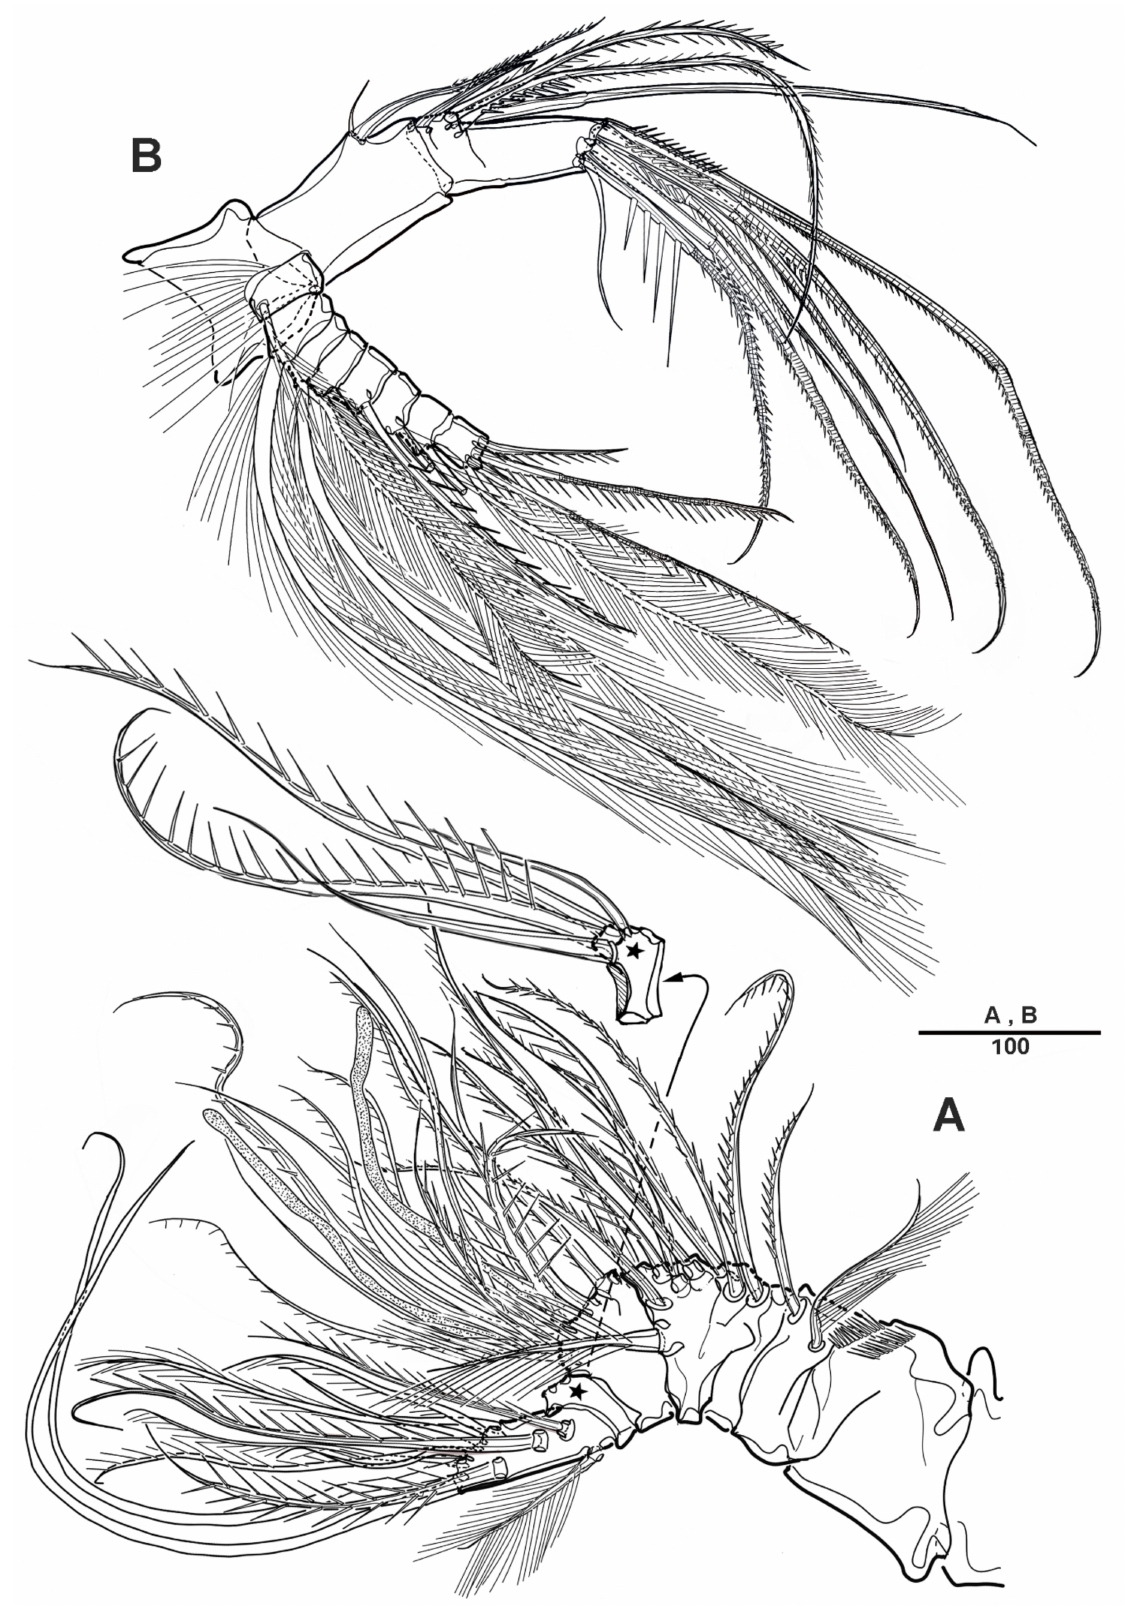
Figure 3. Scottolana daecheonensis sp. nov. holotype female: ( A ) antennule (inset showing armature on segment 3); ( B ) antenna. Scale bars in µ